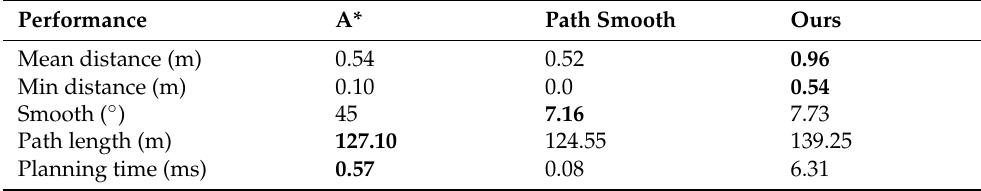
Table 2. The performance index of the generated path in the second experiment.